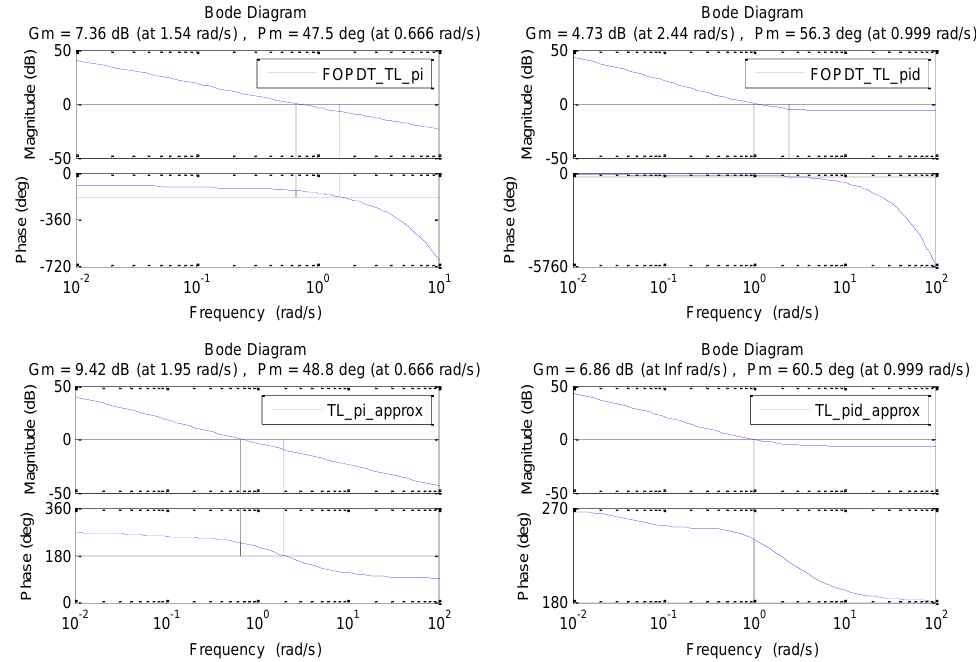
Figure 9. Bode plots of G(s) and G Pade’s (s) with TL controller